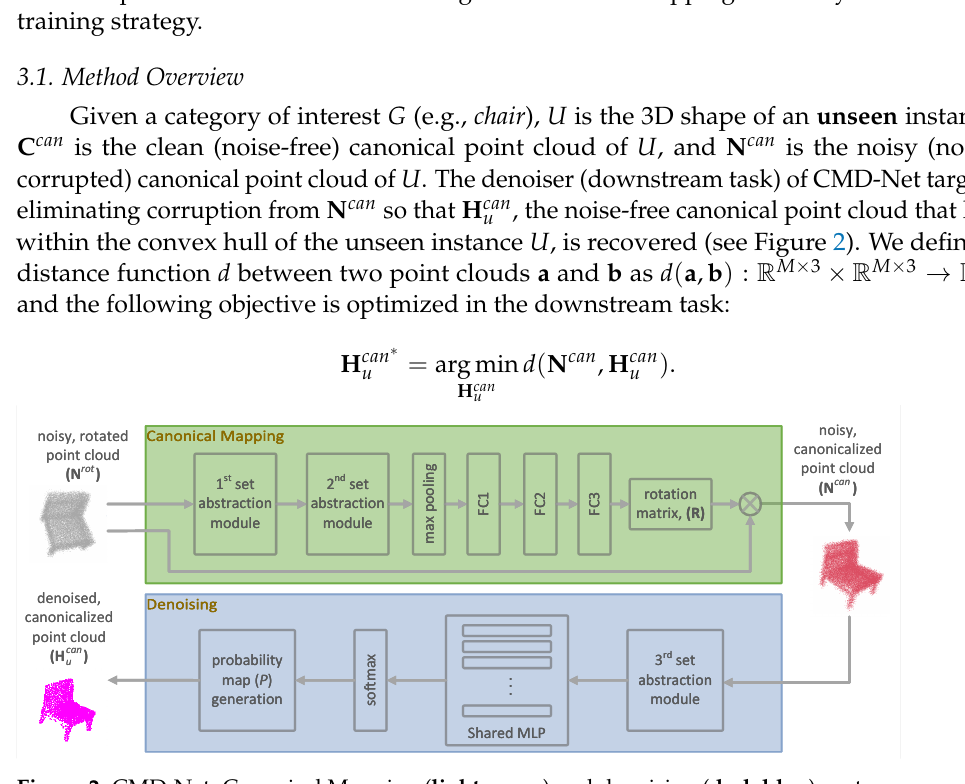
Figure 2. CMD-Net: Canonical Mapping ( light green ) and denoising ( dark blue ) parts are encoder– decoder architectures based on PointNet++. Canonical Mapping (auxiliary task) serves as a proxy for denoising (downstream task). See Section 3 for